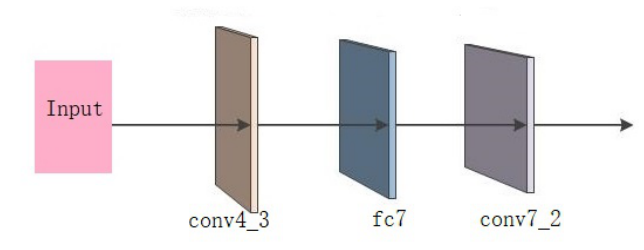
Figure 4. First feature forward